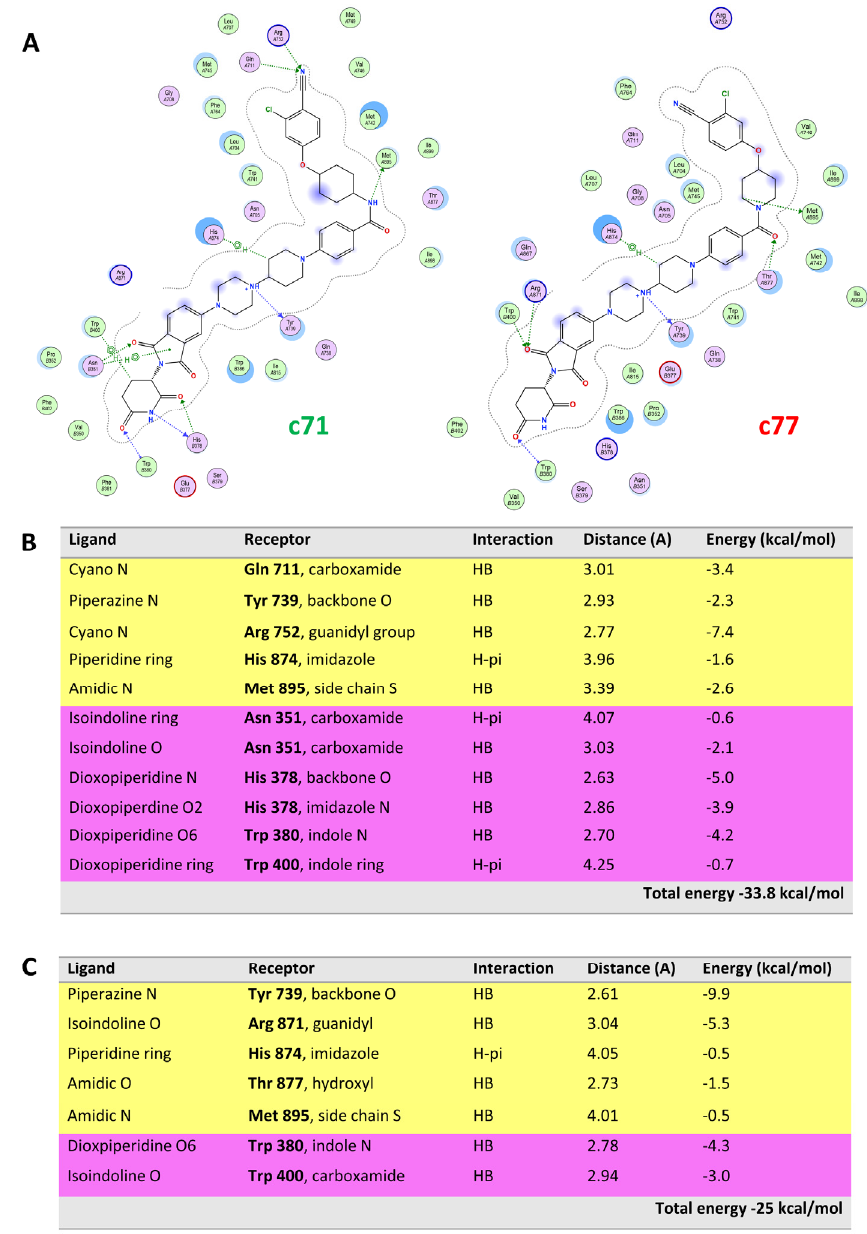
Figure 6. Comparison of c71 (active degrader) and c77 (inactive degrader). ( A ) Ligand interaction chart of c71 and c77. ( B ) c71 table of interactions with AR (yellow) and CRBN (light violet) are reported. ( C ) c77 table of interactions with AR (yellow) and CRBN (light